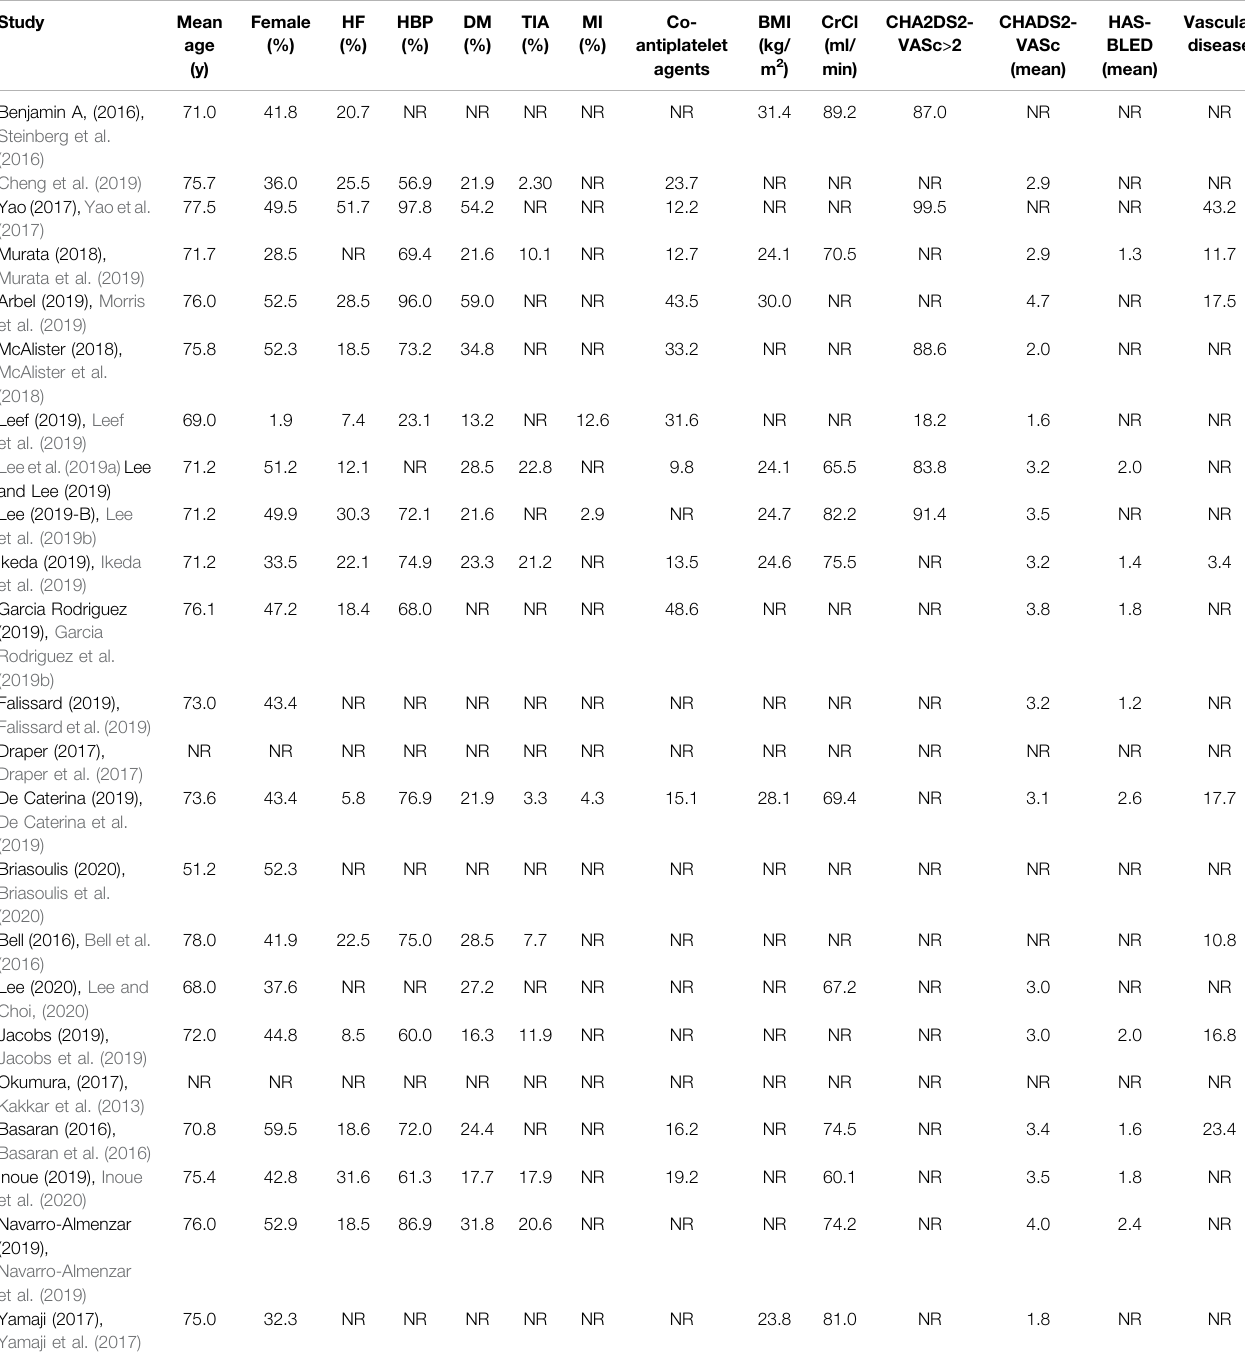
TABLE 3 | Detailed demographics and clinical characteristics of the included